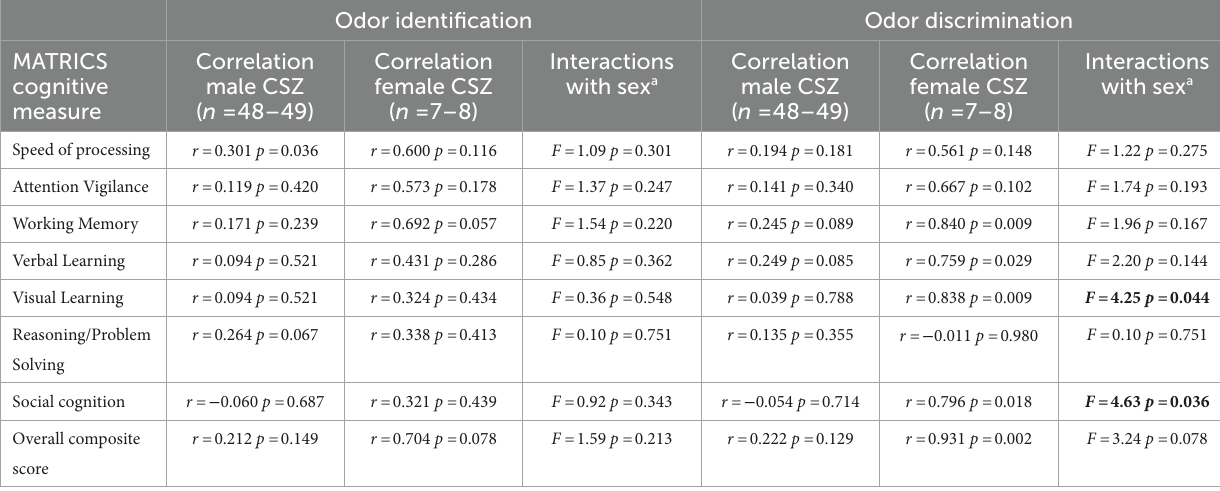
TABLE 6 Correlations between odor identification or odor discrimination scores and cognitive measures and interaction effects between sex and cognitive measures in subjects with Chronic Schizophrenia (CSZ).